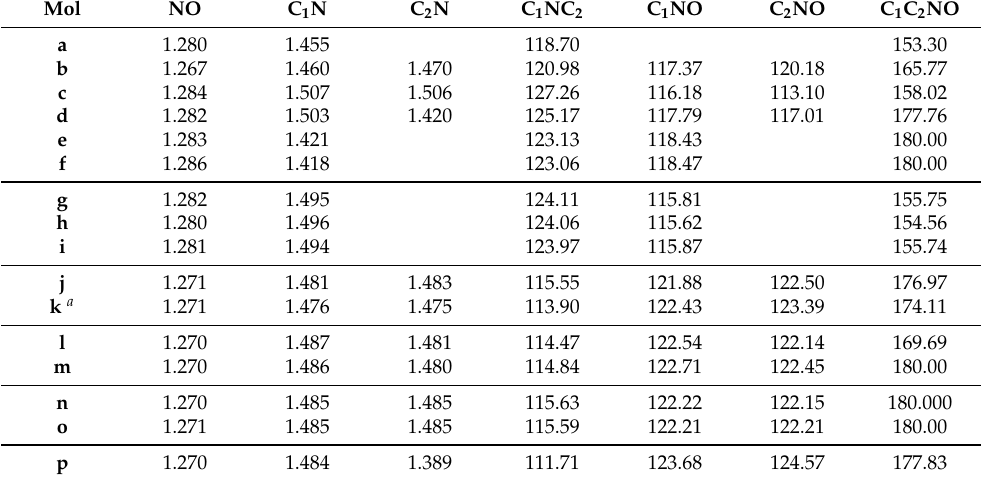
Table 3. Geometric parameters of the selected molecules at the B2 level of